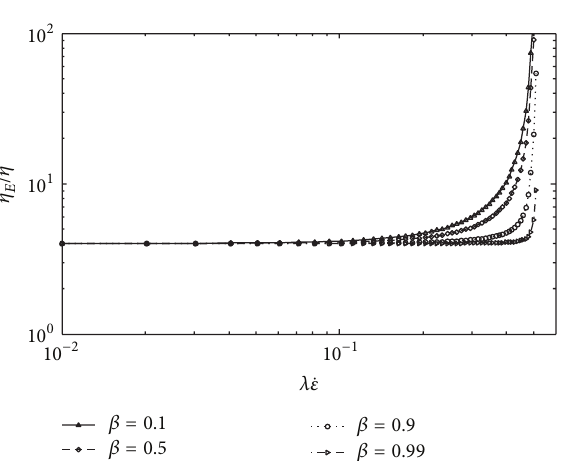
Figure 10: First normal stress difference at 𝑥 = −0.04 for various Wi with 𝛽 = 0.5 and 𝛽 = 0.9